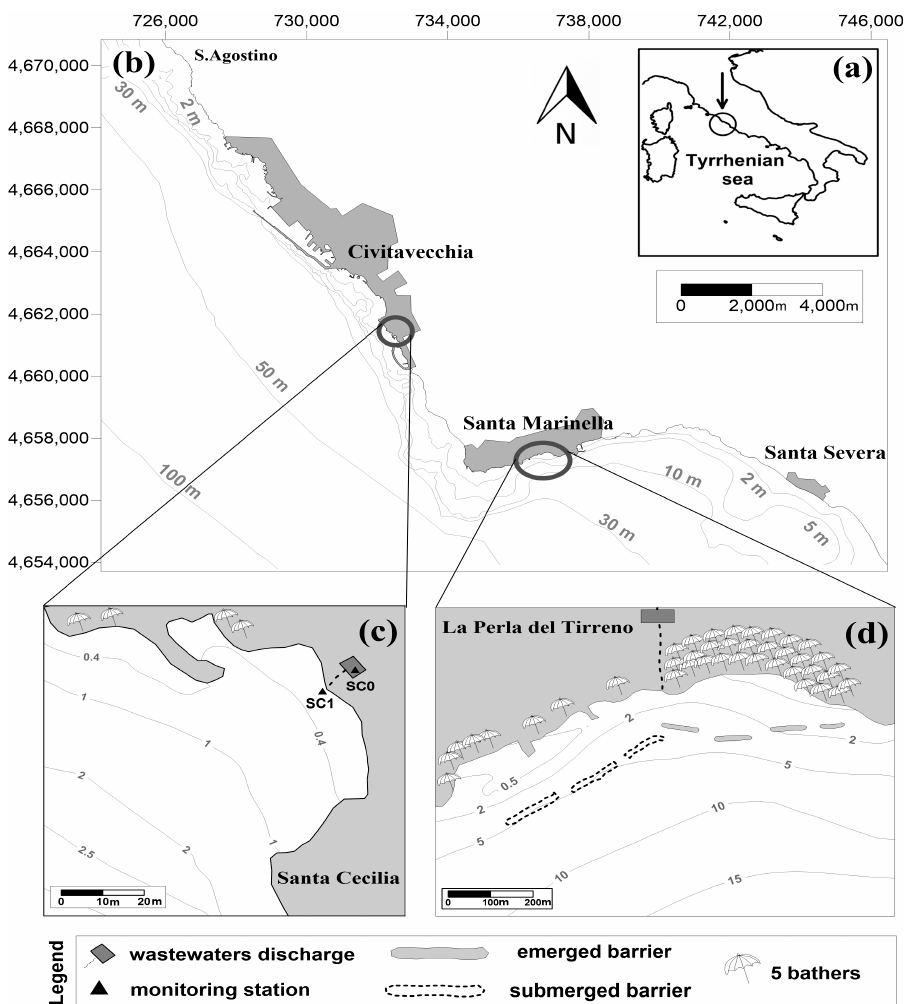
Figure 1. Study area along the Tyrrhenian coast (Latium, Italy, a – b ) Location of the Santa Cecilia, Civitavecchia, ( c ) and of La Perla del Tirreno, Santa Marinella, ( d ) bathing areas. Both the study sites shows the discharge points and bathers density (one umbrella corresponds to five bathers). The coordinate system is expressed in UTM 32 (WGS84).